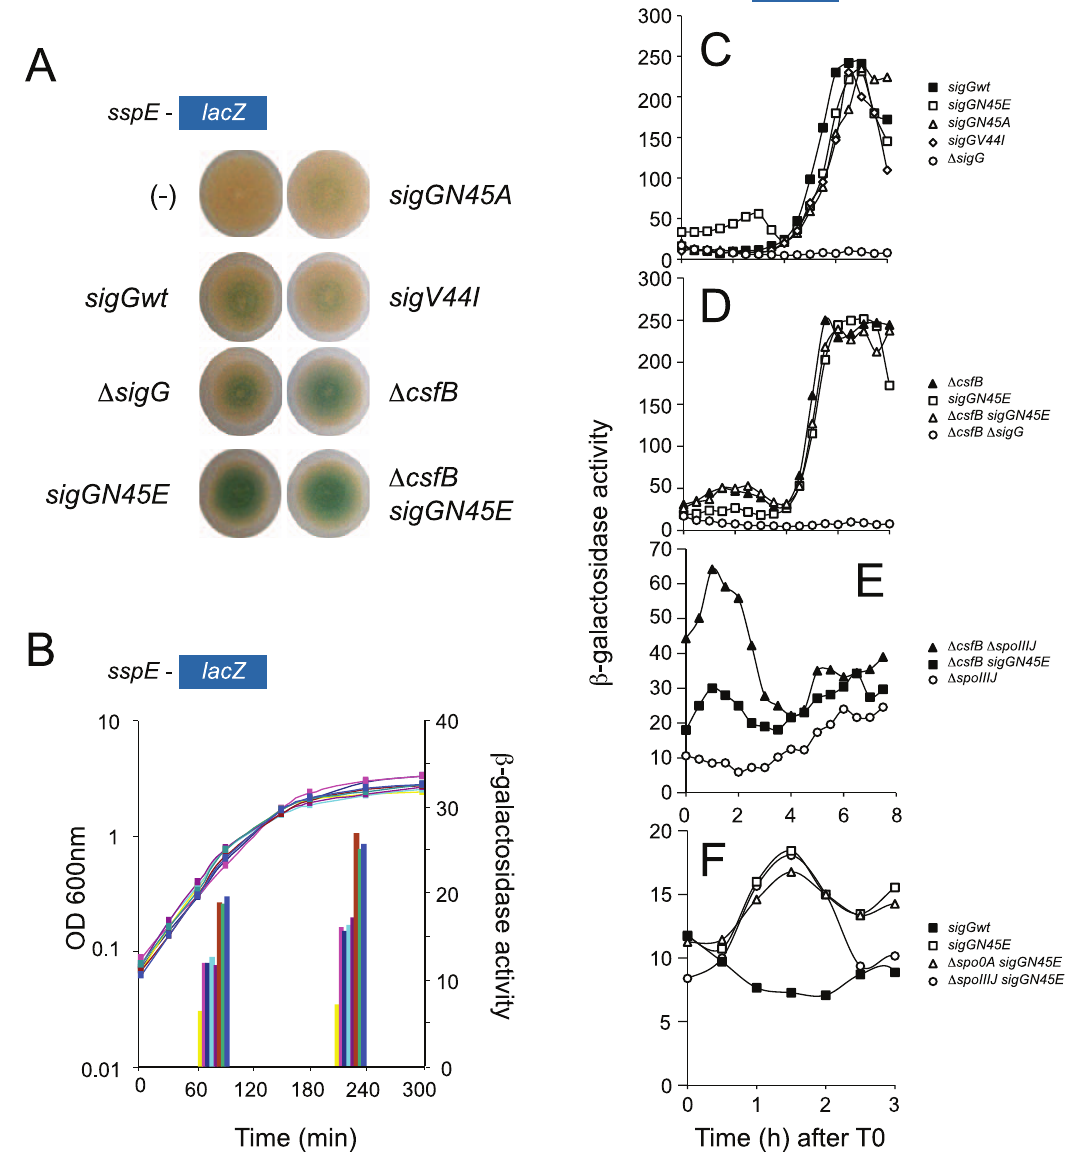
Figure 2. Identification of mutants with increased activity of s G . Panel A illustrates a colony screening for enhanced b -galactosidase production from the s G -controlled P sspE - lacZ reporter fusion on LB plates containing X-Gal. Panel B shows the quantitative analysis of enzyme activity for the same strains shown in A, on liquid LB cultures at mid-log and at the onset of stationary phase. The following strains are shown (Table S1 shows the complete genotype of all strains): wild type background (pink in panel B), sigGN45E (brown in panel B), sigGN45A (light blue in panel B), sigGV44I (purple in panel B), D csfB (green in panel B), and D csfB sigGN45E (blue in panel B). Controls for background levels are the wild type MB24 bearing no reporter fusion (‘‘ 2 ’’ symbol in panel A, yellow bars in panel B), and a strain carrying the P sspE -lacZ fusion in conjunction with a sigG deletion mutation (dark blue in panel B). In panels C, D, E, and F the activity of wild type s G or its mutant forms s GN45A , s GN45E , or s GV44I was examined during sporulation in DSM medium in a wild type background or in strains carrying mutations in genes known to control the initiation of sporulation or to influence the activity of wild type s G . All strains used in this analysis carry the s G -controlled P sspE -lacZ fusion. Panel C, shows the activity profile for wild type s G , and for s GN45E , s GN45A , or s GV44I in an otherwise wild type background. Residual expression of P sspE - lacZ in a D sigG mutant is included for reference. Panel D compares the activity of wild type s G in a D csfB mutant to the activity of s GN45E in a wild type background or in a D csfB mutant. Expression of P sspE - lacZ in a D sigG D csfB mutant is also represented. Panel E compares the activity of wild type s G in a D spoIIIJ mutant and a D spoIIIJ D csfB double mutant to that of s GN45E in a D spoIIIJ mutant. Panel F shows the activity s GN45E in a wild type background, or in the absence of sigF or spo0A (AH6626, open triangles). The activity of wild type s G in a wild type background is shown for reference. The various strains were grown in sporulation medium (DSM) and sampled at hourly intervals after T0 (denoting the end of the logarithmic phase of growth). b -galactosidase activity is shown in Miller Units. In all cases, the various forms of s G are produced from the wt or sigG mutant alleles present at the sigG locus. Panels C-F show the results of representative experiments, which in all cases were conducted independently at least three times.